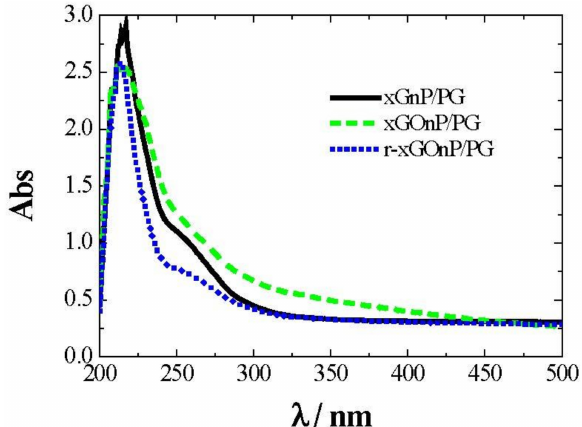
Figure 5. UV ‐ Vis absorption spectra of xGnP/PG (solid line), xGOnP/PG (dashed line), and r ‐ Figure 5. UV-Vis absorption spectra of xGnP/PG (solid line), xGOnP/PG (dashed line), and xGOnP/PG (dotted line) nanofluids, 0.003 wt %, T = 298.15 K. r-xGOnP/PG (dotted line) nanofluids, 0.003 wt %, T = 298.15 K.